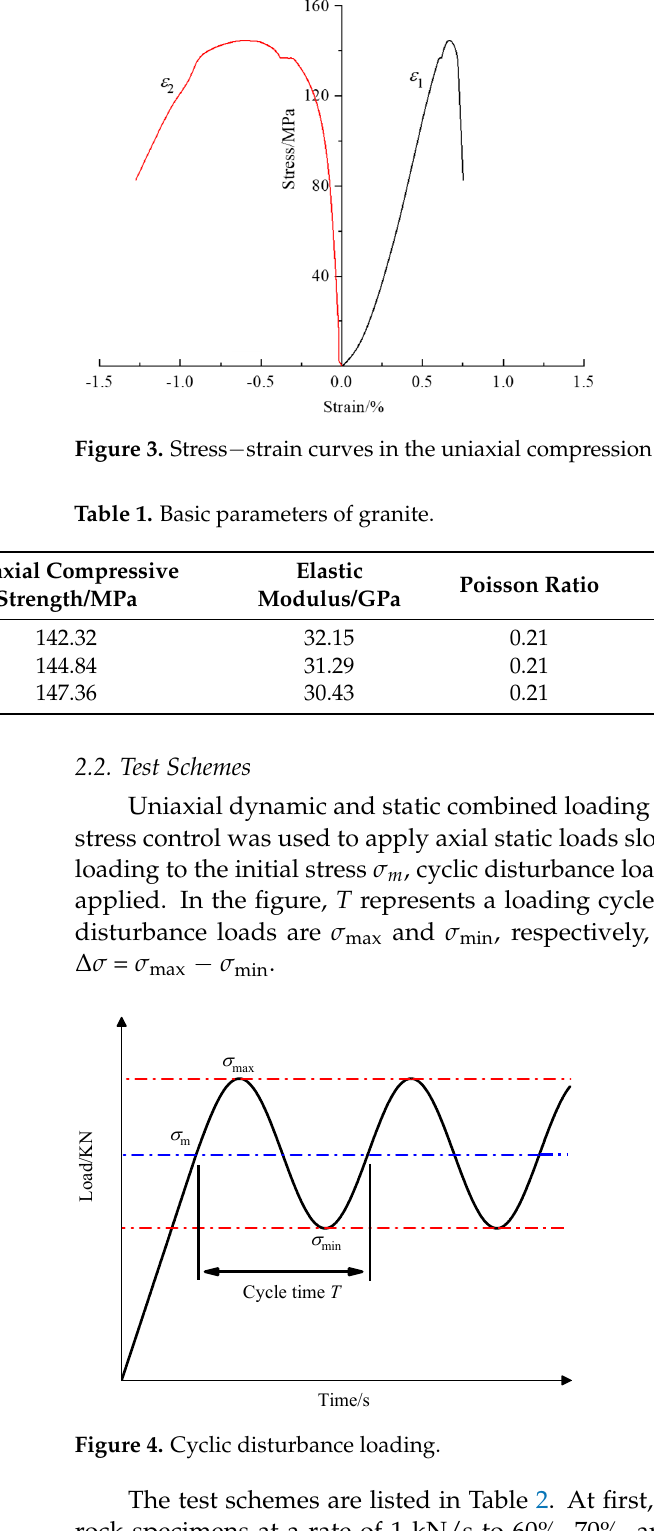
Table 1. Basic parameters of granite.